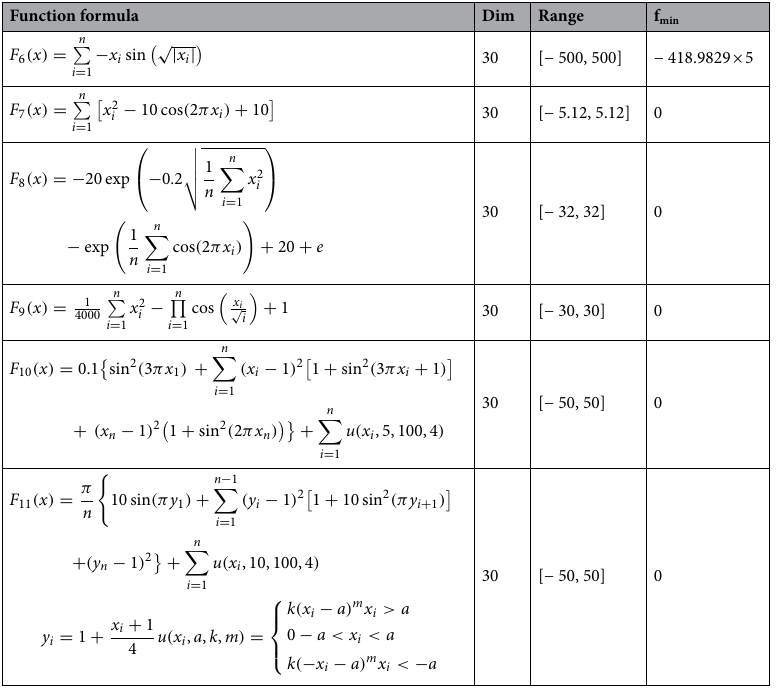
Table 3. Multimodal functions.